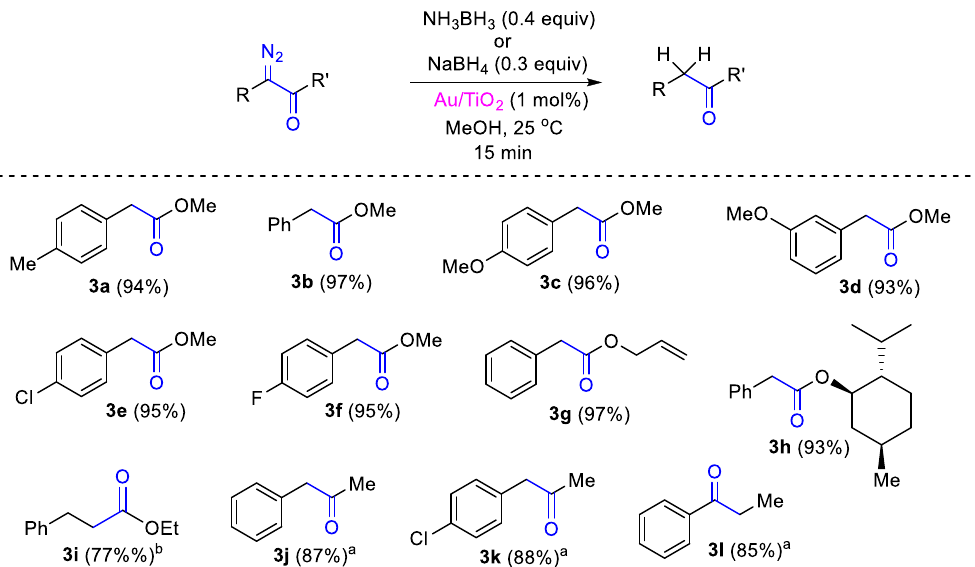
Figure 1. Reduction of α-diazocarbonyl compounds by NH 3 BH 3 or NaBH 4 catalyzed by Au/TiO 2 . a With one additional B-H equivalent, the corresponding alcohols of the ketones 3j – l were isolated in > 90% yield. b In this case, the corresponding hydrazone (Ε/Ζ = 85/15) was formed in 15% relative yield using NH 3 BH 3 and in 25% with NaBH 4 . The isolated yield refers to the reaction with NH 3 BH 3 .